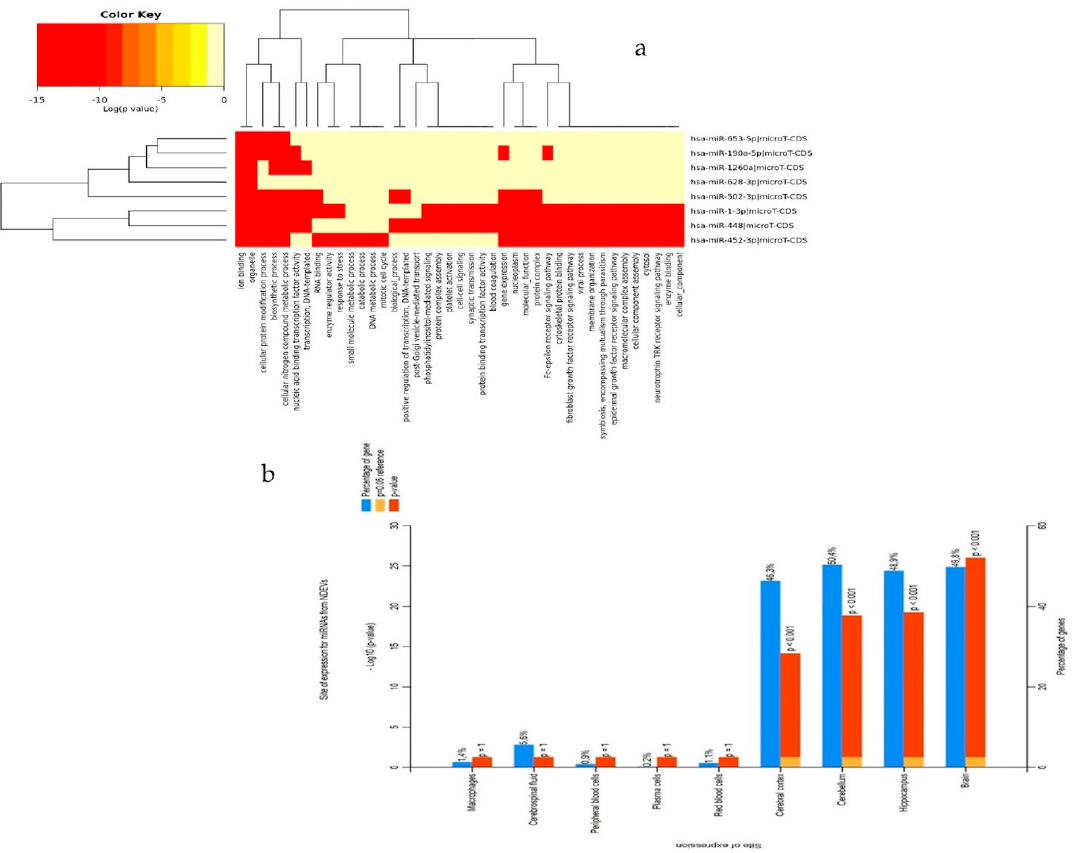
Figure 9. ( a ) Heatmaps of significant pathways predicted by DIANA-miRPath (v.3.0) for specific miRNAs detected in NDEVs. Pathways are depicted on the X -axis and miRNAs on the Y -axis. The color code represents the log ( p -value), with the most significant predicted miRNA-pathway interactions in red. ( b ) Tissue site of expression determined using FunRich v3.0 (http://funrich.org/). The percentage of targets showing regional enrichment (blue bar) and the significance of regional enrichment (red bar). Top x -axis is –log10 ( p -value) of regional enrichment; bottom x -axis is the percentage of targets overlapping with the region.